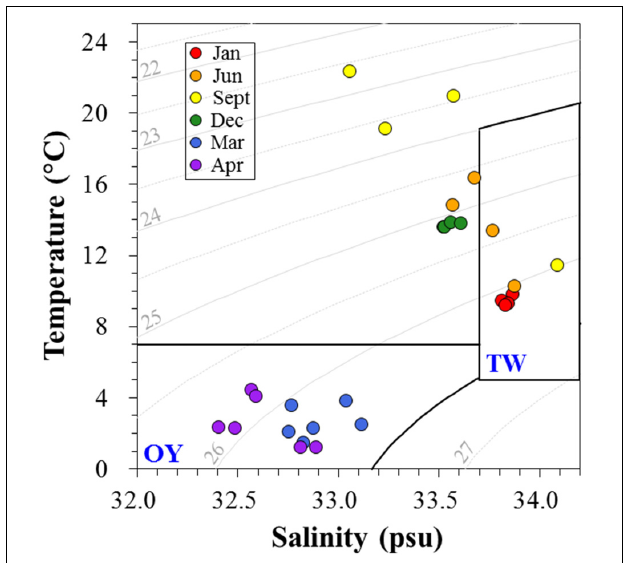
FIGURE 5 | The temperature-salinity (TS) diagram depicts the presence of different water masses in the Sanriku coastal area during the sampling periods. The criteria proposed by Hanawa and Mitsudera (1986) were used to distinguish the typical water properties of the Oyashio (OY) and Tsugaru Warm (TW)